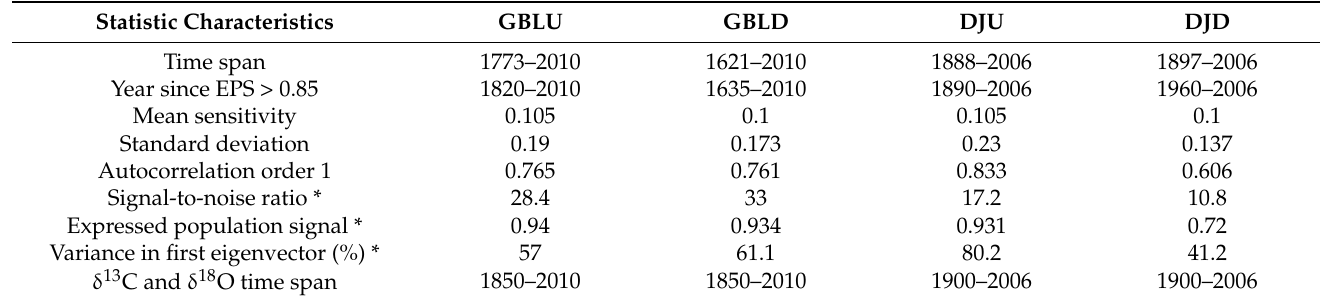
Table 1. Statistic characteristics of the tree-ring width chronologies. Each of the two transects (GBL and DJ) consisted of forest stands of two elevations, i.e., a treeline plot (U) and low-elevation plot (D). Statistic Characteristics GBLU GBLD DJU